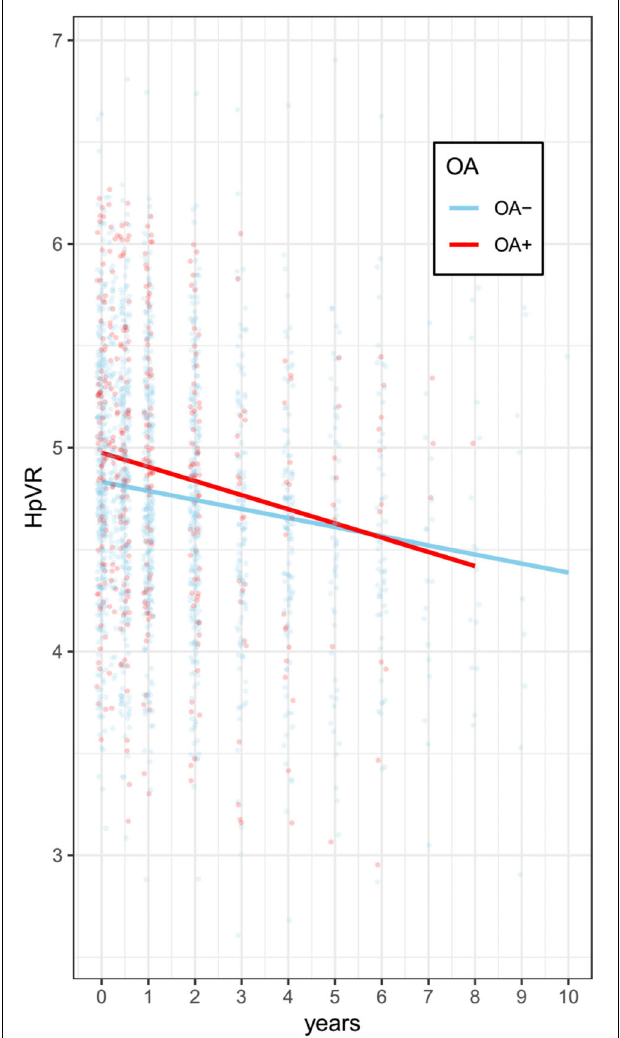
for both groups. As shown in Supplementary Table 1 and Supplementary Figure 1 , compared with individuals without OA, those with OA showed a significantly steeper decline in HpVR (estimate: − 0.015, p = 0.0127) after adjusting for other potential